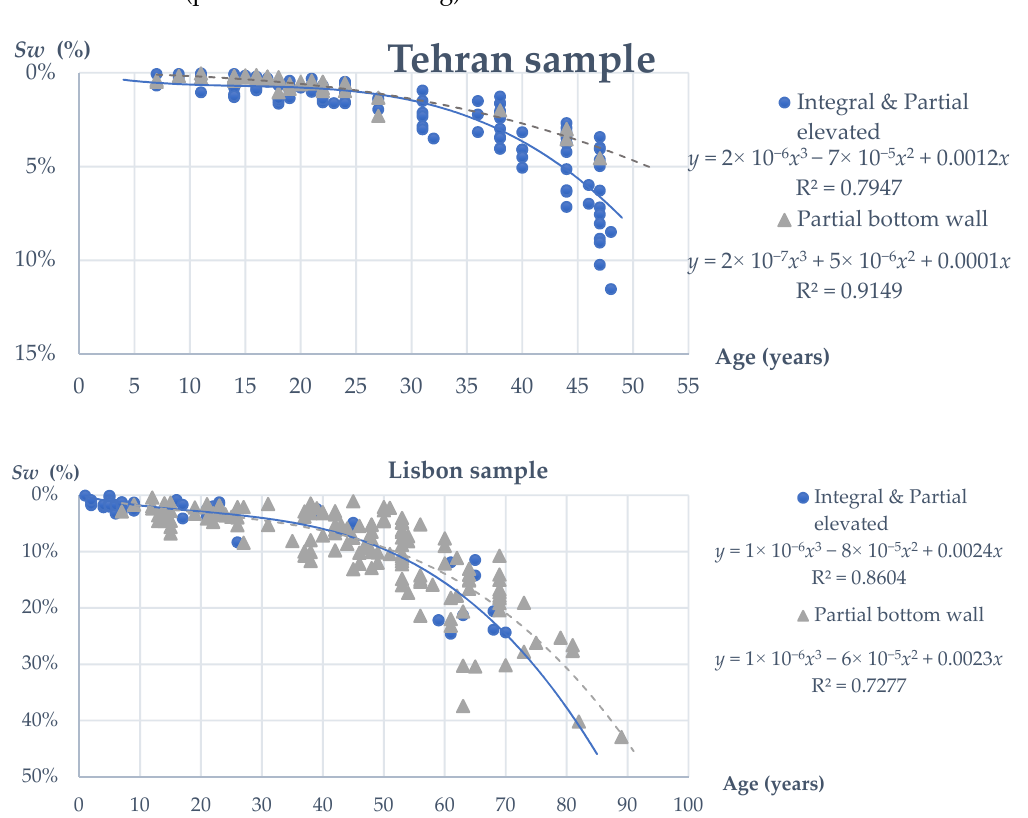
Figure 13. Degradation curves of the Tehran and Lisbon samples, according to the location of the cladding.